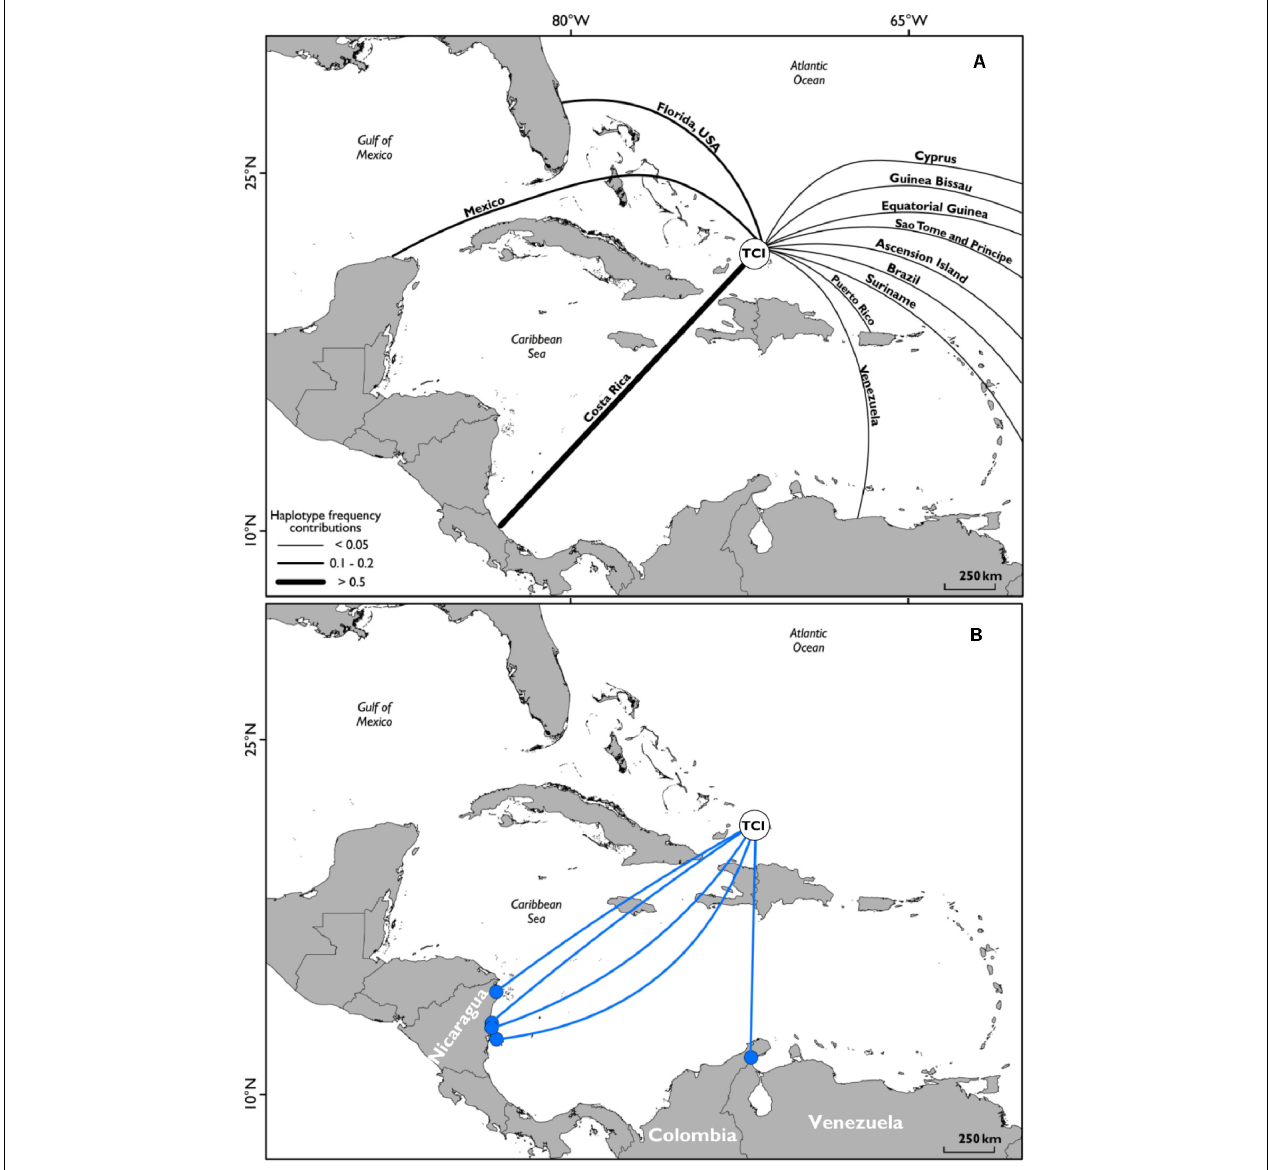
FIGURE 3 | (A) Geographic distribution of mitochondrial DNA haplotype frequency contributions to green turtles captured in Turks and Caicos waters from all known potential rookeries; adapted from data produced in Richardson et al. (2009). (B) Locations of international flipper tag recaptures. Deployment area of all flipper tags on green sea turtles (white filled circle, labeled TCI), and locations of recapture of individuals ( n = 5; blue filled circles), with representative linkage routes (blue lines). Countries of recapture locations